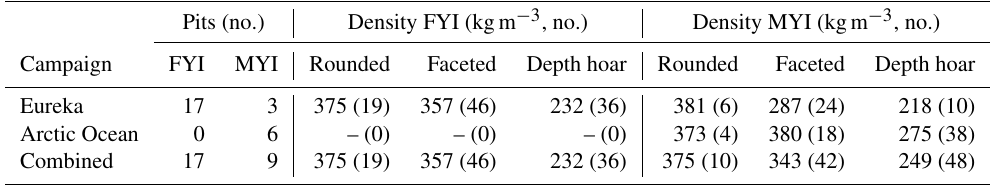
Table 4. Mean density cutter measurements from snow pits separated by layer type and campaign. Pits (no.) Density FYI (kgm − 3 , no.) Density MYI (kgm − 3 ,